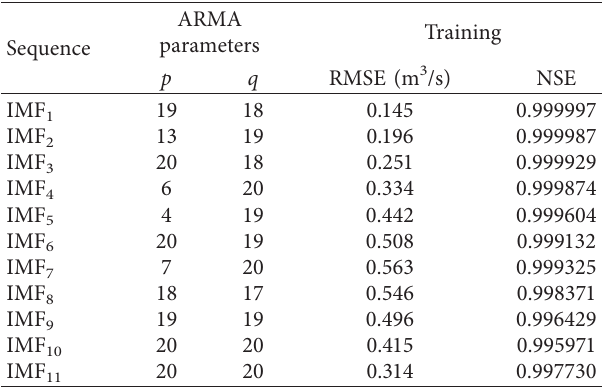
Table 6: Evaluation of a BPNN with 1 hidden layer for the IMF1 of VMD at the Weijiabao